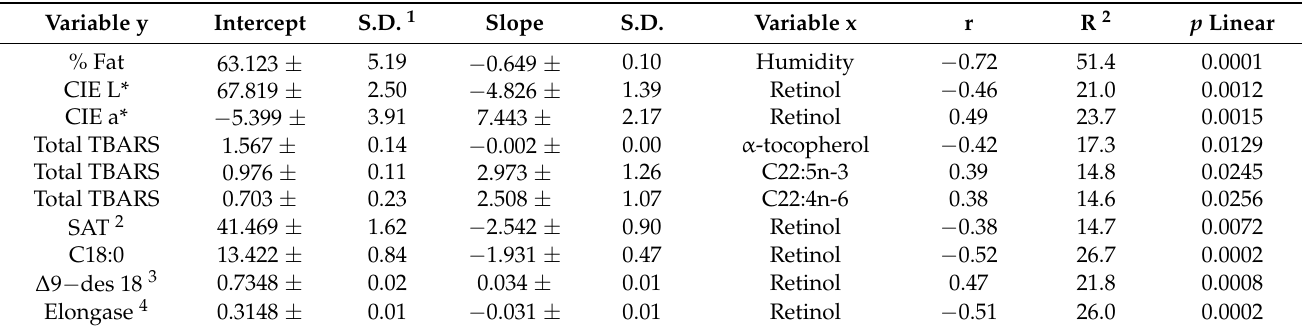
Table 8. Regression equations between different parameters of quality traits and yolk composition. Variable y